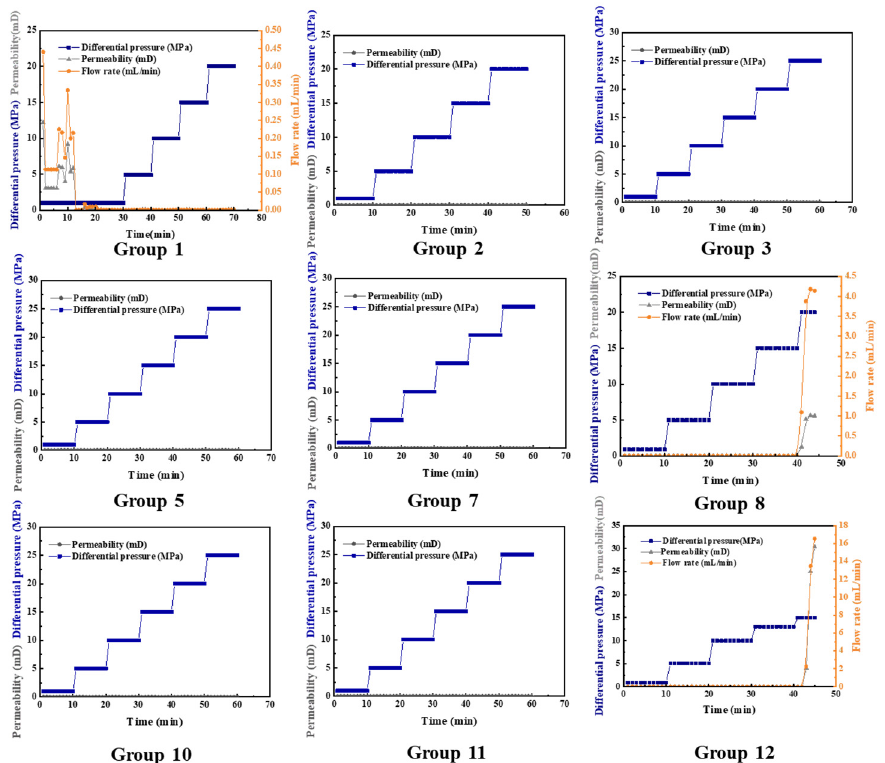
Figure 6. Plugging curves of different groups.